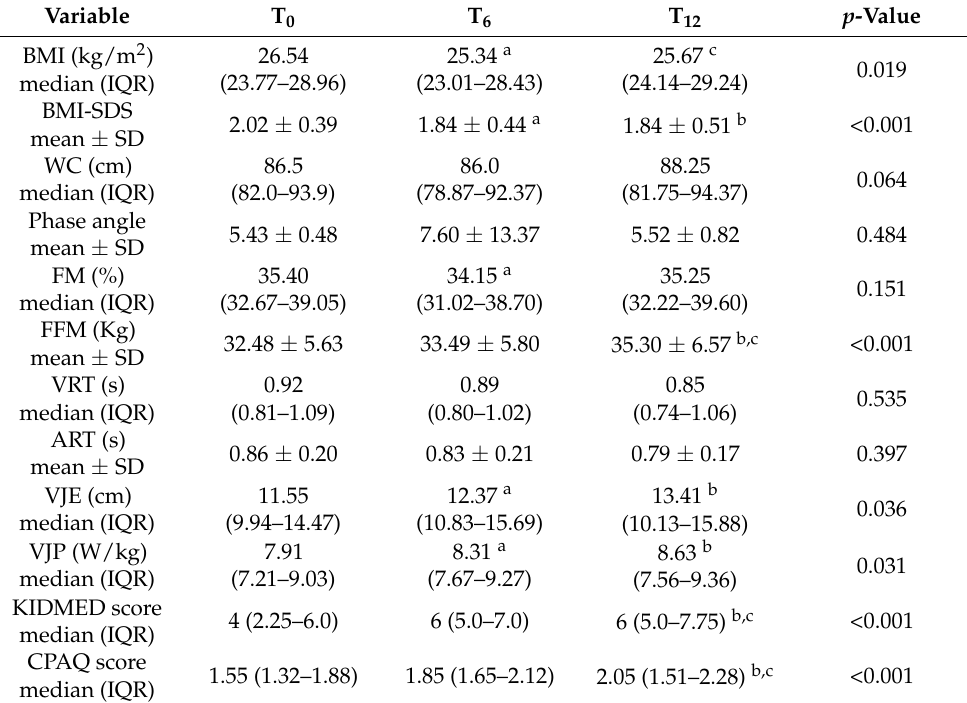
Table 1. Changes in children’s (n = 40) anthropometric, motor and behavioral variables across the three times of